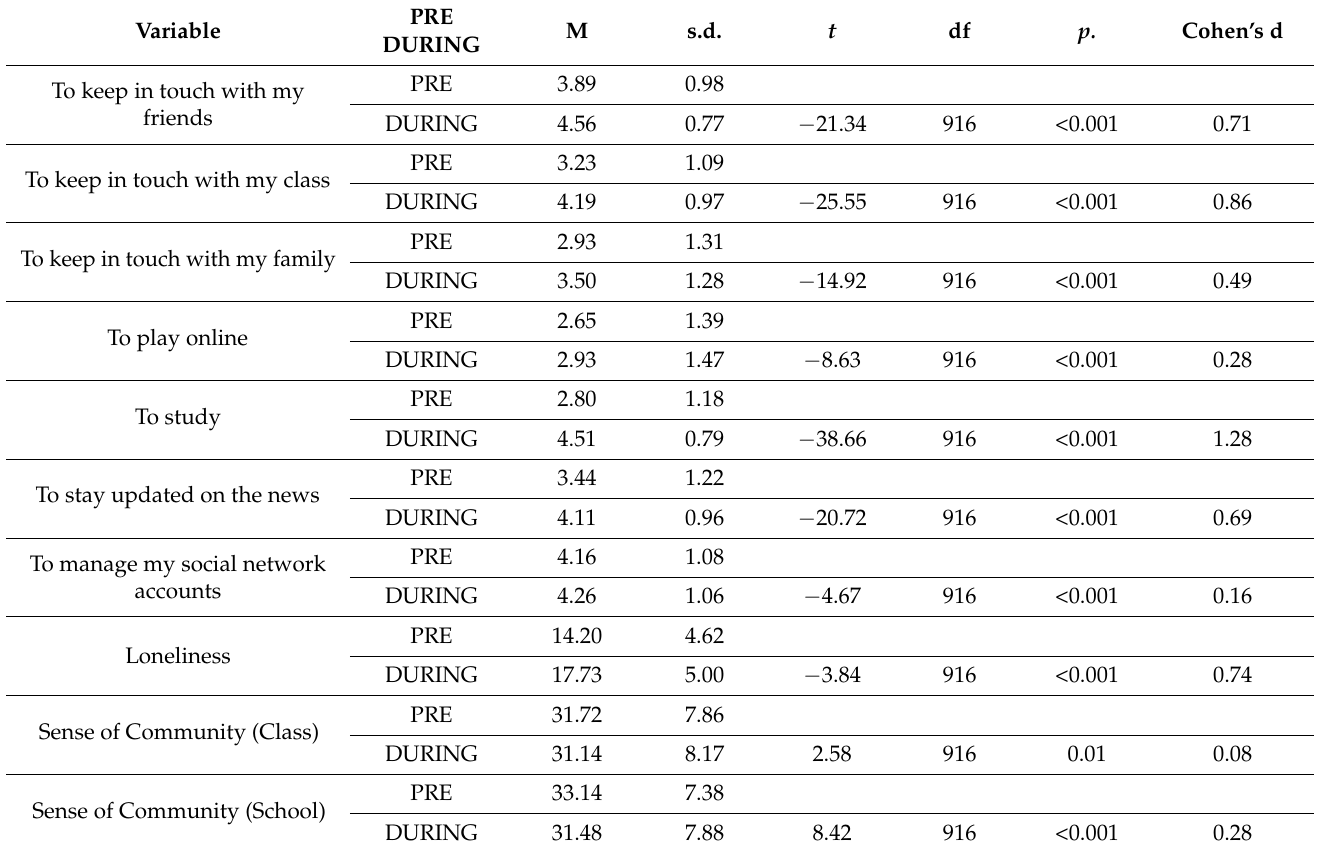
Table 1. Paired Student’s t -test for assessing differences between the pre-pandemic and current